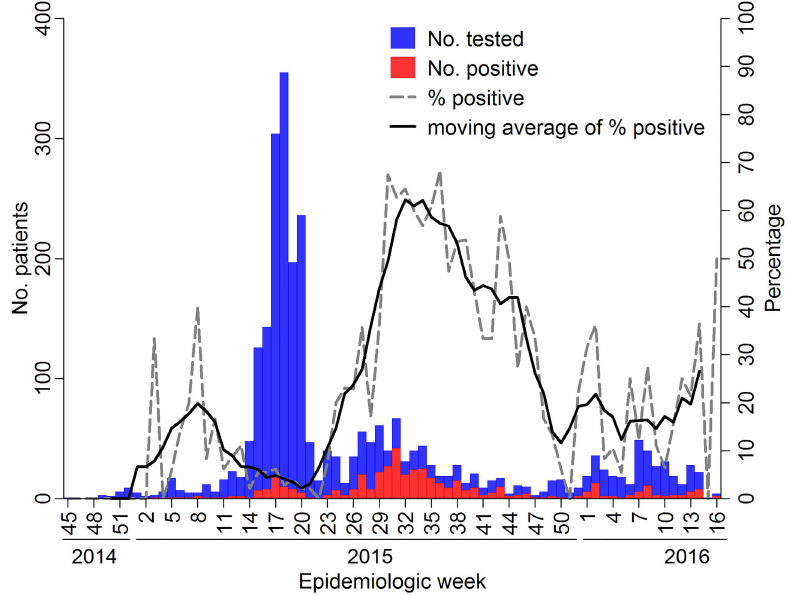
Fig 1. Epidemiological curve of absolute and relative frequencies of Chikungunya detection by epidemiological week, Salvador, Brazil.